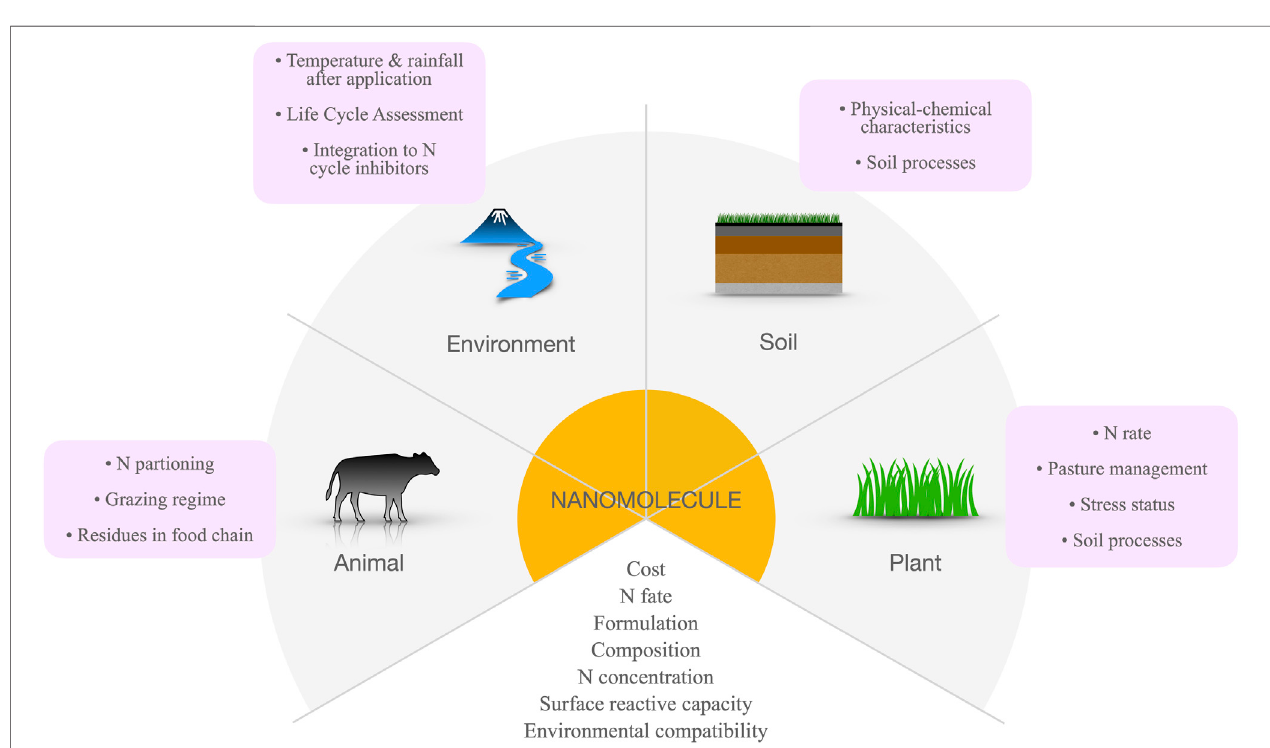
FIGURE 1 | Determining factors for the development of new fertilizer application strategies using nanofertilizers in pastures.